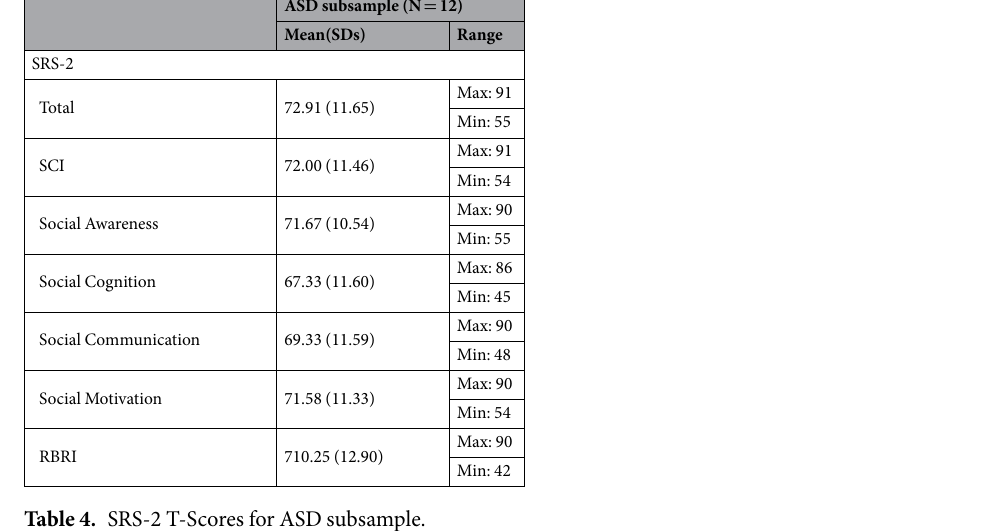
Table 4. SRS-2 T-Scores for ASD